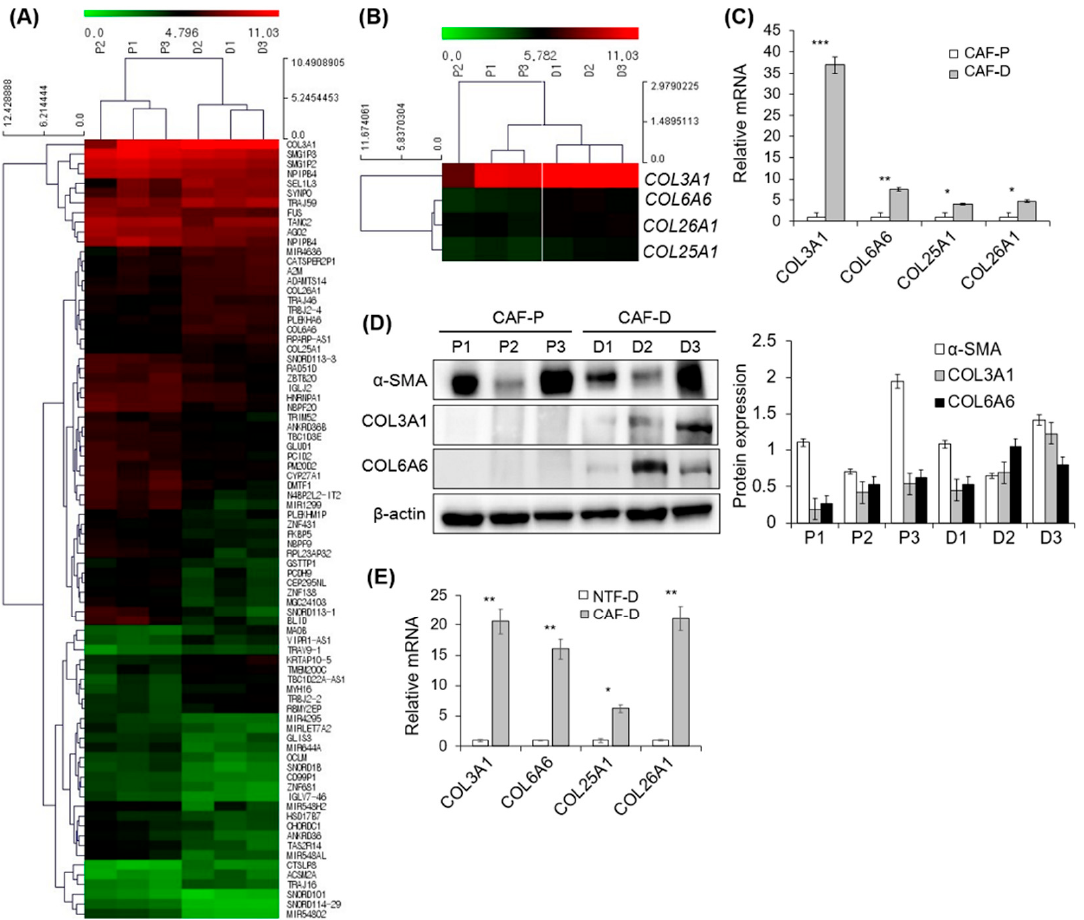
Figure 4. DNA microarray analysis of CF-P and CAF-D group. To evaluate the gene expression difference between CAF-P and CAF-D groups, microarray analysis with six samples of three primary fibroblasts in each group was performed with Affymetrix GeneChip ® Human Gene 2.0 ST array. ( A ) Heatmap of differentially expressed genes among the matched groups with a fold change of >1.75 and p -value of <0.05. ( B ) Heatmap of COL3A1 , COL6A6 , COL25A1 , and COL26A1 in two groups. ( C ) The mRNA expression levels of four collagen genes were compared using qPCR analysis in the CAF-P and CAF-D group fibroblasts. ( D ) Collagen protein expression was compared in the same sample groups. ( E ) mRNA expression of four COL genes was compared in four sets of CAF-D and paired NTF-D. Results represent the mean ± standard deviation of three experiments (* p < 0.01, ** p < 0.005, *** p < 0.0001).